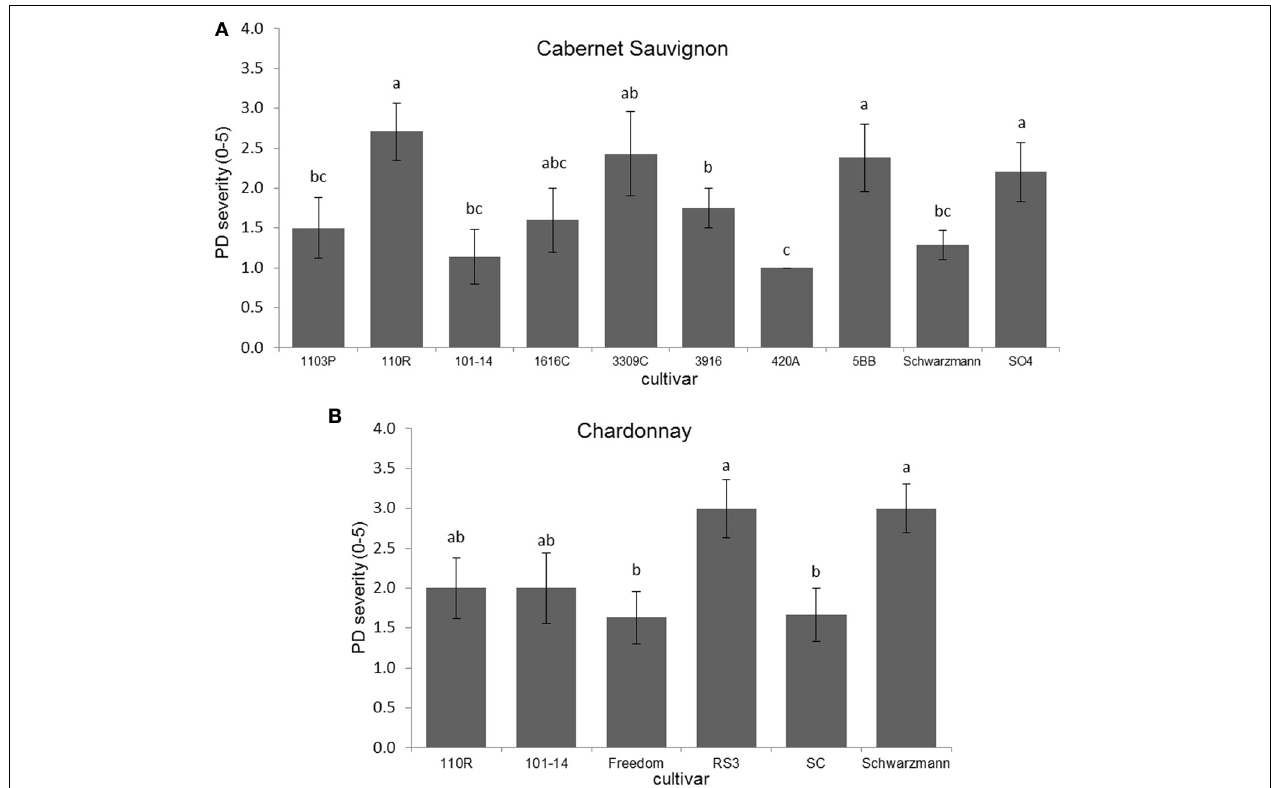
FIGURE 1 | Disease severity of (A) Cabernet Sauvignon or (B) Chardonnay scion on various rootstock cultivars. Letters represent differences pairwise by Mann–Whitney U -tests. Bars indicate SE. See text for full descriptions of rootstocks.